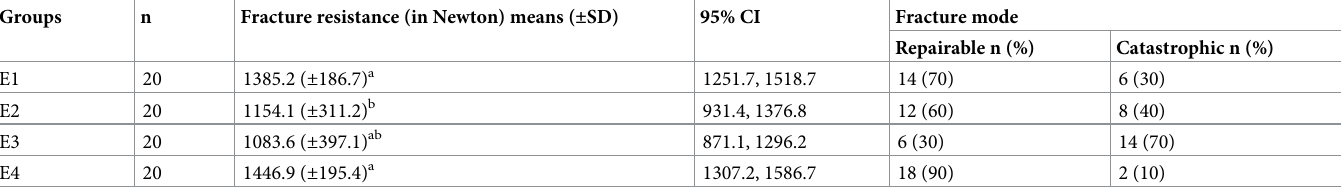
Table 1. Results of fracture resistance and fracture modes.